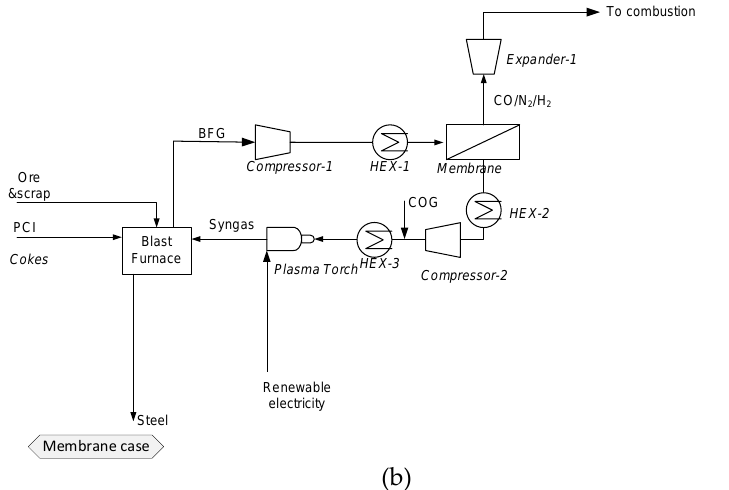
Figure 3. Process flow diagram of the ( a ) Reference case and ( b ) Membrane configuration. When membranes are used for the CO 2 separation, the BFG needs to be compressed, cooled and fed to the membrane separation unit. The units are operated with vacuum at the permeate side of the membrane, so the permeate CO 2 rich stream needs to be re-compressed before mixing with COG. In addition, for the membrane case it is important to limit N 2 crossover to the permeate side. Increased N 2 crossover results in the accumulation of the inert gases as a result of the blast furnace gas recycle loop. This would result in increased compression power and an increase of the membrane surface area. Therefore, the two scenarios presented in Figure 4, when applying one or two stage membrane configurations, were evaluated, with the main goal of enhancing CO 2 recovery and minimizing N 2 crossover to the permeate side.